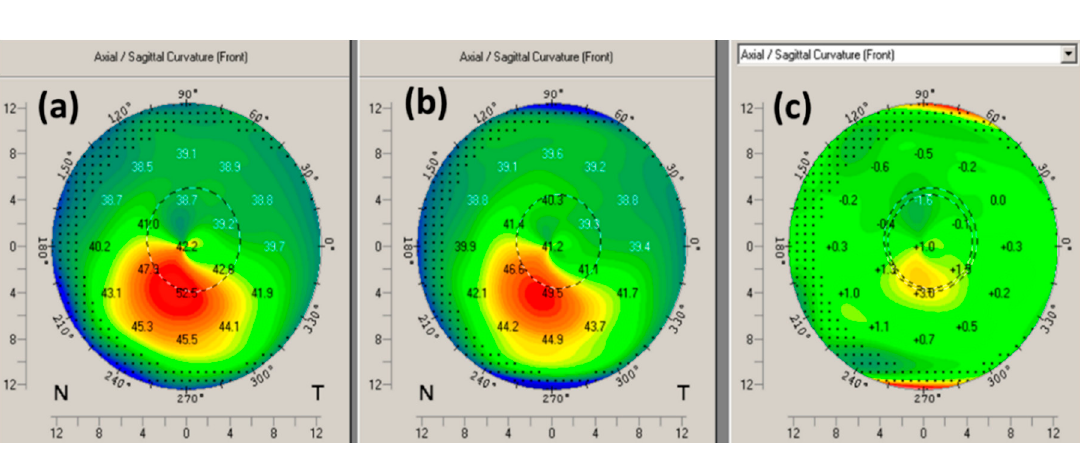
Figure 4. Distribution in changes in Kmax from preoperative values at 1-year post-procedure.